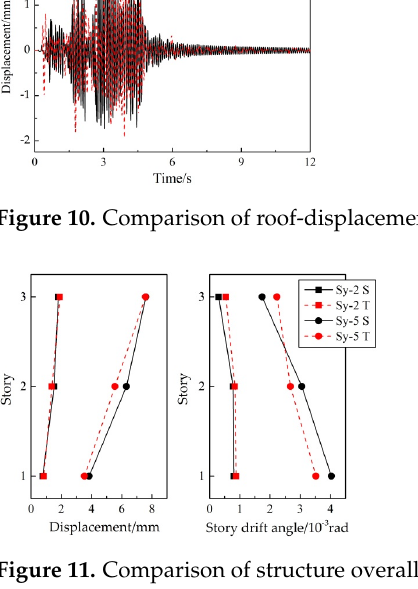
Figure 12. Ground-motion-suite response spectra.